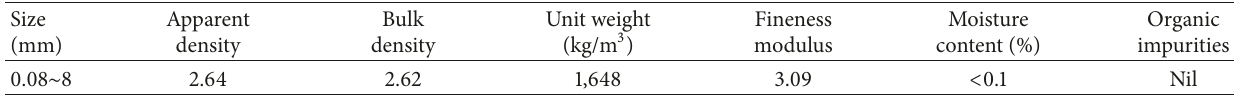
Table 5: Physical properties of aggregate.